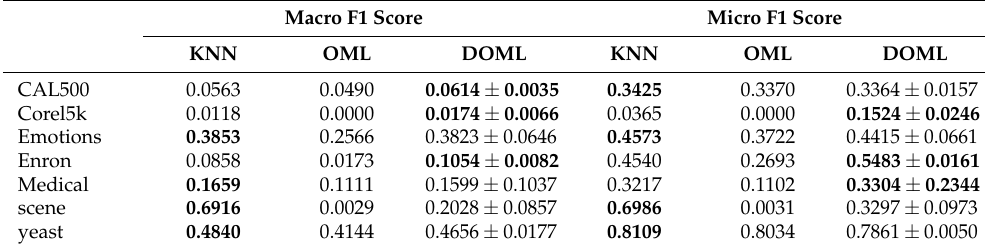
Table 4. F1 Score of different algorithms with full benchmark datasets.